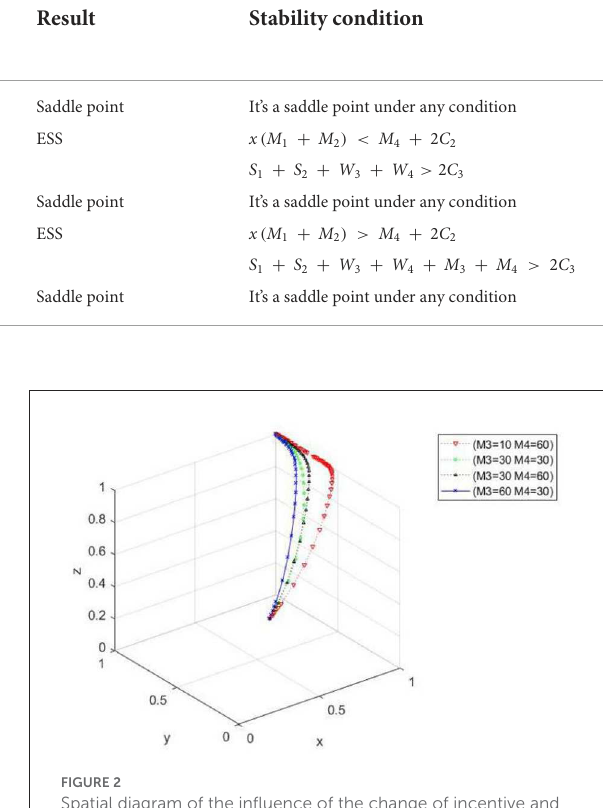
FIGURE1 Spatial diagram of the influence of changes in incentive and punishment on the evolutionary paths of cooperatives given by the government.